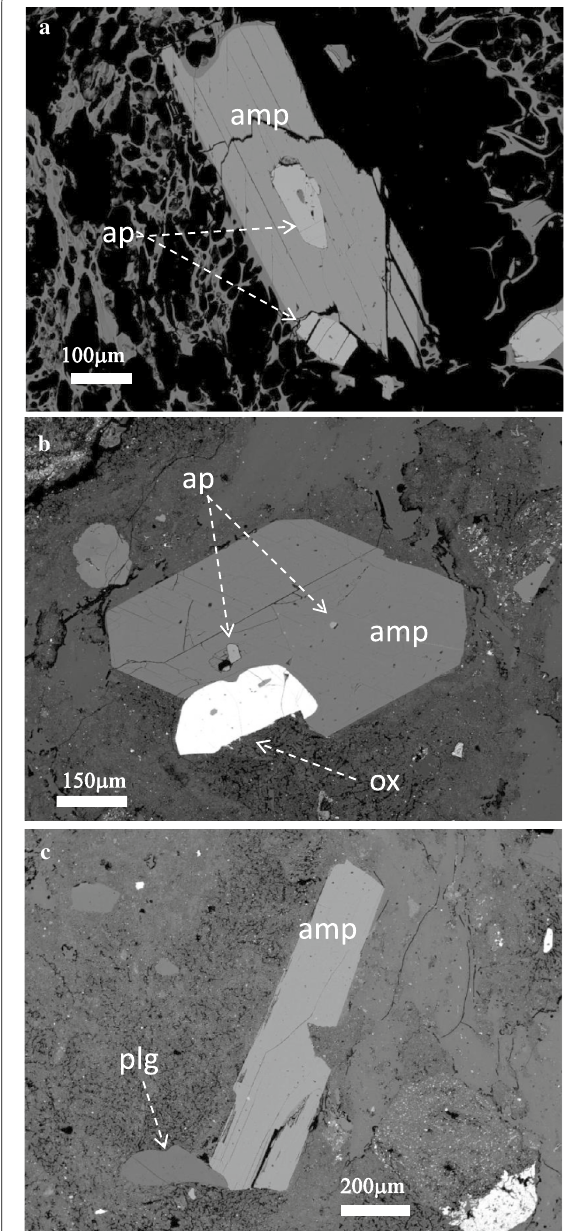
Fig. 2 BSE images of amphibole phenocrysts in samples: a 4I-1w and b , c 4I-1p. Abbreviations are as follows: amphibole (amp), plagioclase (plg), Fe–Ti oxide (ox), and apatite